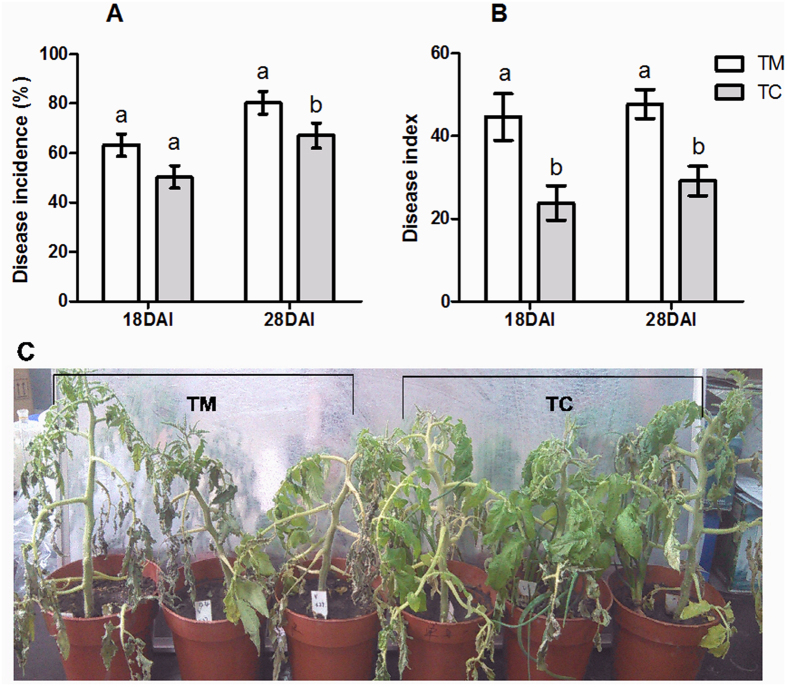
Effects of companion cropping with potato onion on the disease incidence and index of tomato verticillium wilt.TM indicates tomato monoculture; TC indicates tomato grown with potato onions. (A) Disease incidence. (B) Disease index. (C) Picture of disease symptom. The data are represented as the means ± SD, n = 3. The small letters above the column represent significant differences between two groups of mean values (p < 0.05).